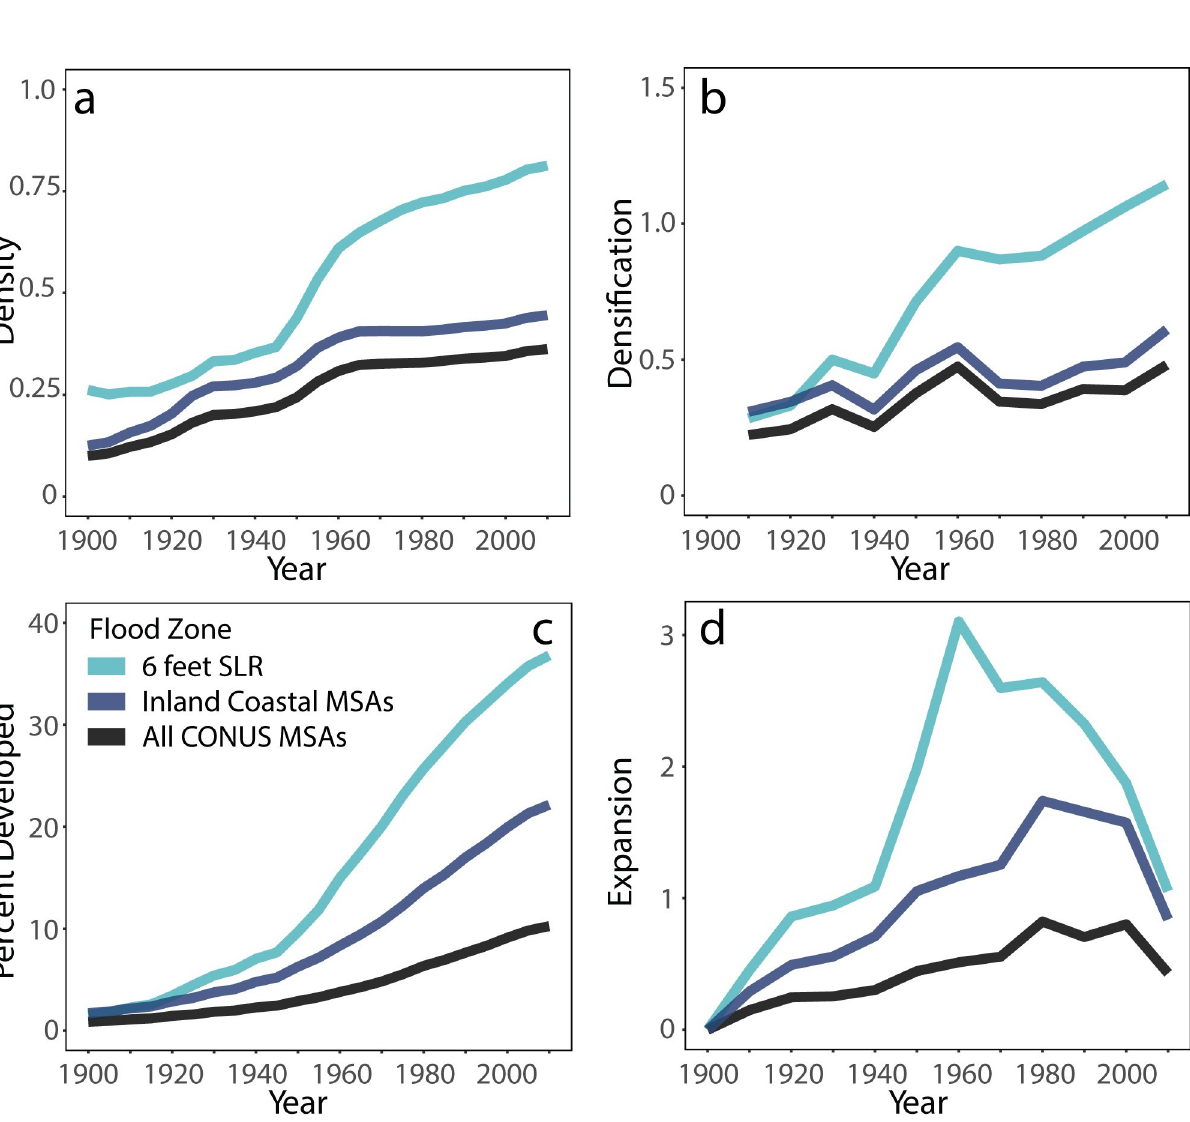
Fig 3. The 6 feet SLR zone, the inland part of coastal Micro- and Metropolitan Statistical Areas (MSAs; without SLR zone), and all MSAs of the conterminous United States (CONUS) show over time: a) increasing density (structures per grid cell) of developed area; b) recent increases in densification (structures added relative to expansion; values greater than 1 mean that density is increasing faster than the addition of developed land grid cells; c) a steady increase in built-up percentage (percentage of grid cells developed within the MSA or SLR zone); and d) changing rates of expansion of developed area (increase in developed grid cells) with steep increases between 1950 and 1970, and dramatic decreases after 1980. Densification (b) and expansion (d) were calculated over 10-year time increments. Compared to all MSAs across CONUS, SLR zones and coastal MSAs are denser, more developed, and consistently have higher rates of expansion than MSAs across the country as a